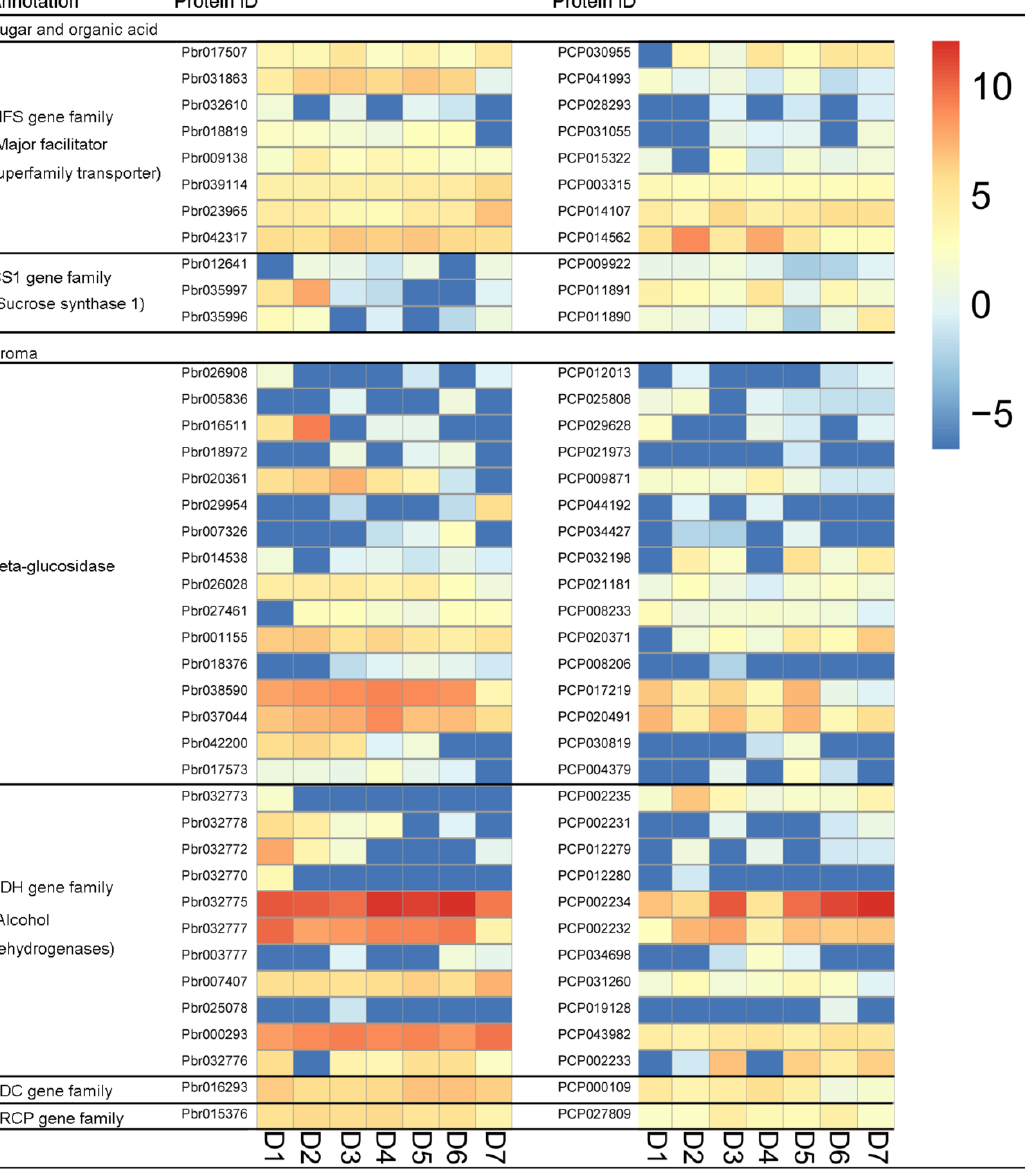
Figure 3. Expression divergence analysis for the related to fruit quality orthologous genes among Pyrus bretschneideri and Pyrus communis. D1, D2, D3, D4, D5, D6, and D7 indicates 15 days after full blooming (15 DAB), 30 DAB, 55 DAB, 85 DAB, 115 DAB, mature stage, and fruit senescence stage. The higher expression of genes was shown using the red shades and lower expression of genes was shown with the blue shades.